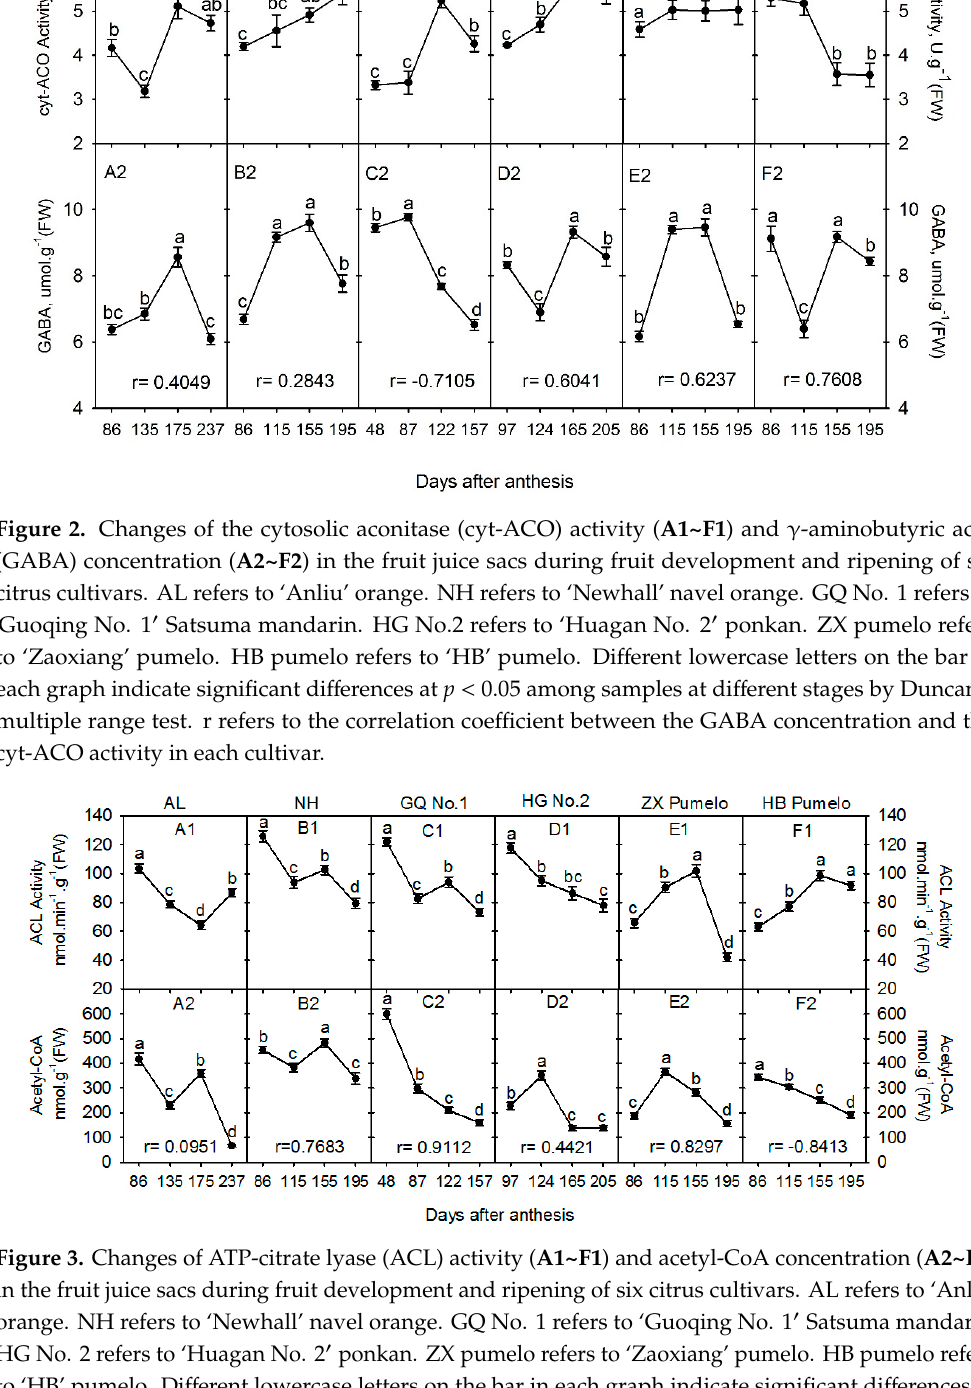
(FW) in ‘Newhall’ navel orange (Figure 3B2). In ‘Guoqing No. 1 ′ Satsuma mandarin, the acetyl-CoA concentration at 48 DAA was the maximum [598.4 nmol. g − 1 (FW)], and then significantly decreased to 159.3 nmol. g − 1 (FW) at 157 DAA (Figure 3C2). In ‘Huagan No.2 ′ ponkan (Figure 3D2) and